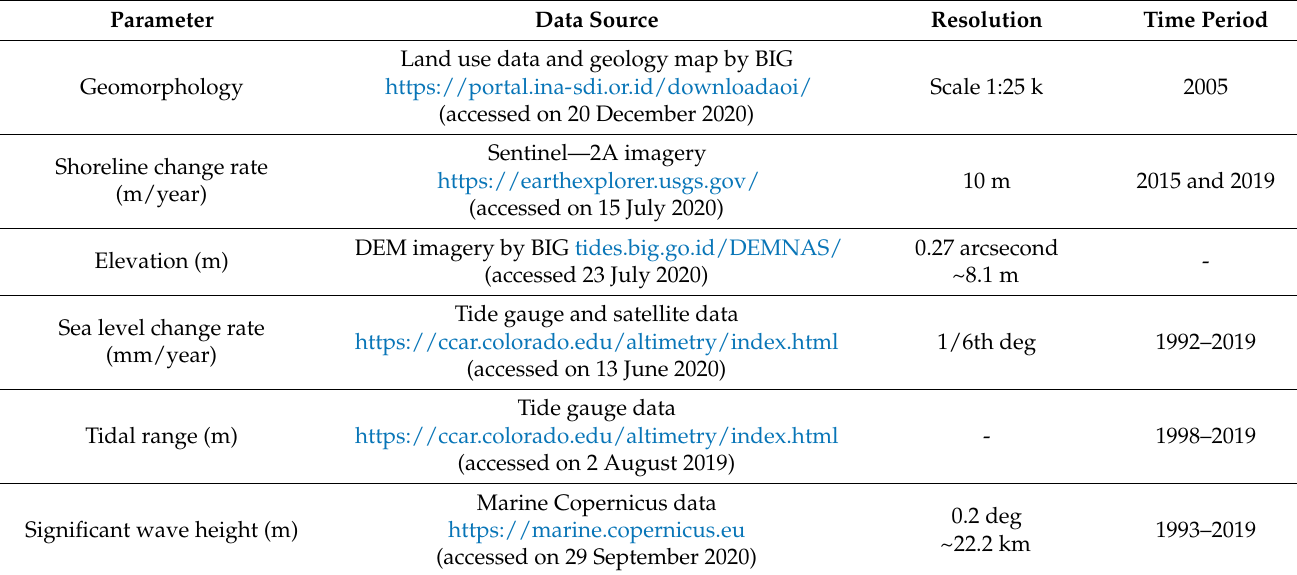
Table 1. Sources and period of the different usage parameters in the compiling of CVI.